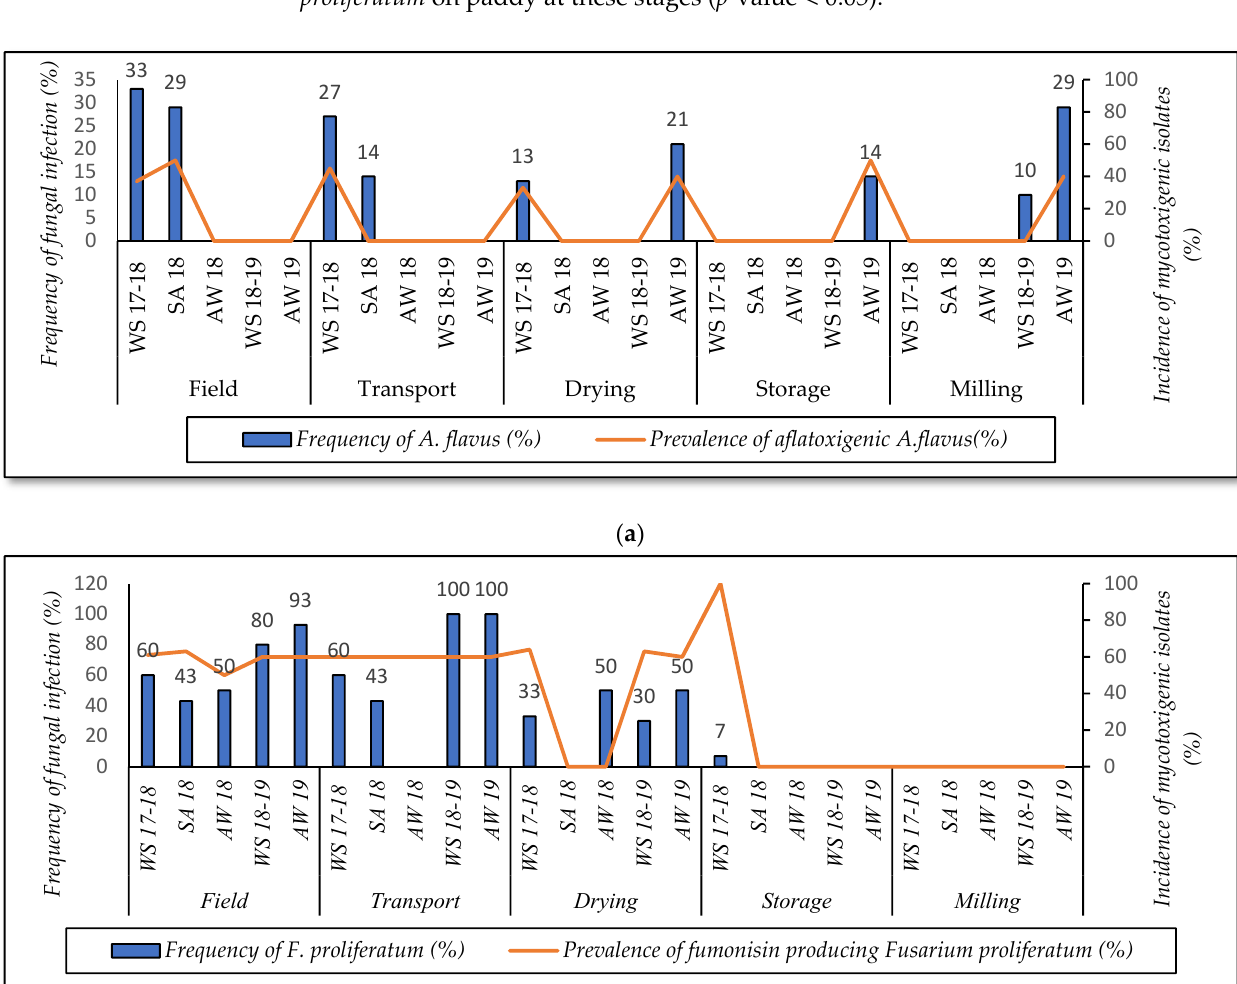
Figure 4. Percentage of A. flavus ( a ) and F. proliferatum ( b ) contaminated rice samples and mycotoxigenic isolates in five